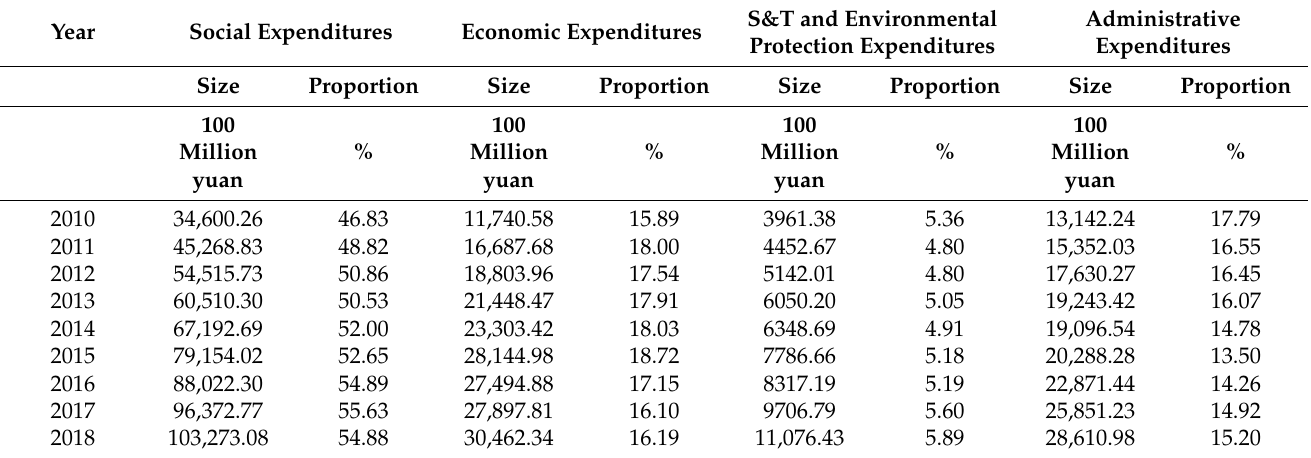
Table 1. Size and proportion of various types of public expenditure in Chinese local